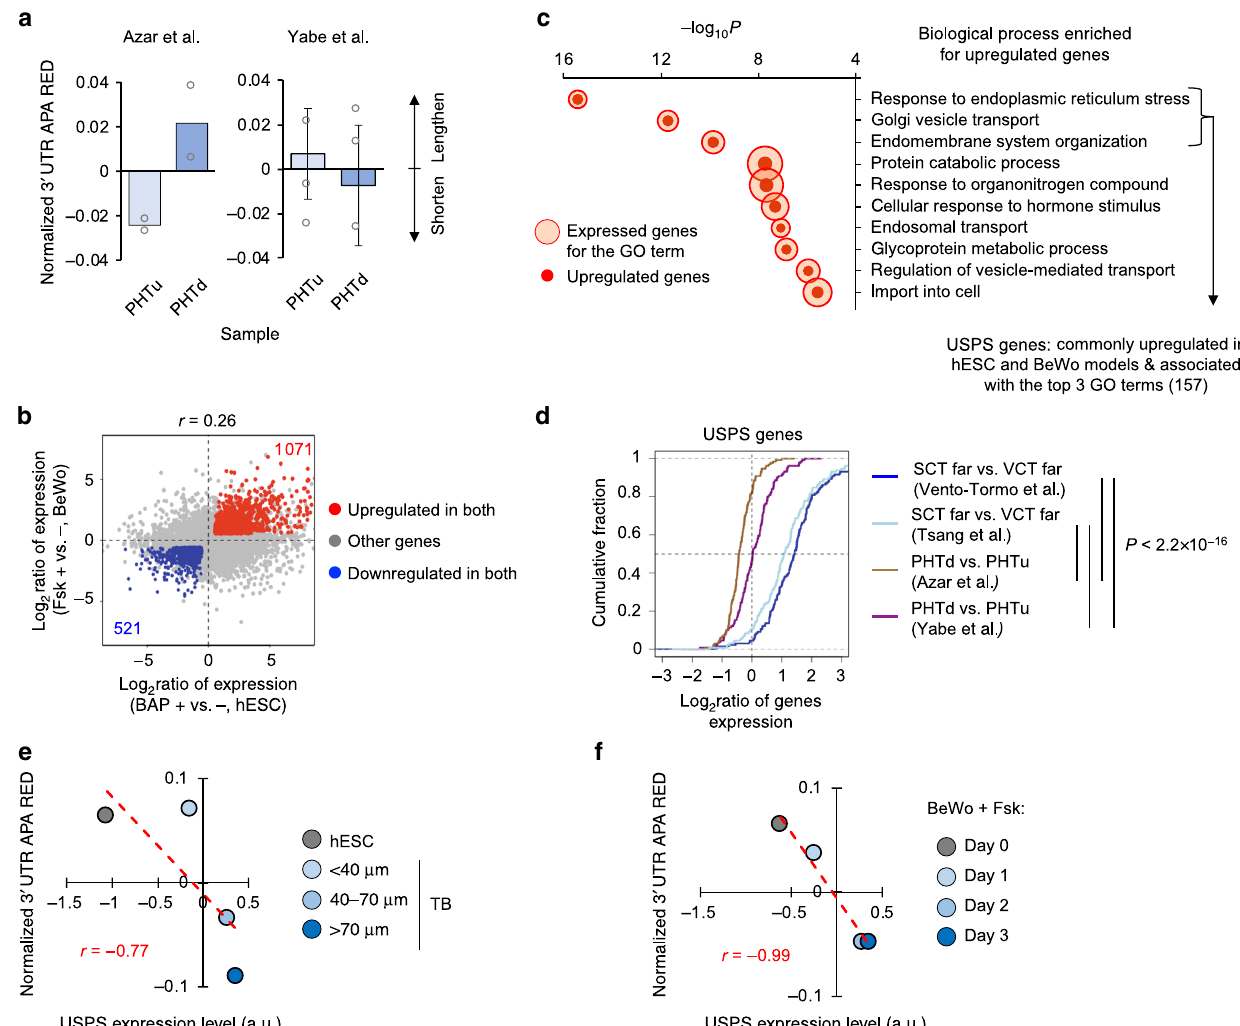
Fig. 5 Integrative analysis connects 3 ʹ UTR size regulation to protein secretion. a 3 ʹ UTR APA analysis of in vitro syncytialization of primary human trophoblast (PHT) cells. PHTu and PHTd are mononucleated PHT cells and syncytialized PHT cells, respectively. 3 ʹ UTR APA REDs are normalized to mean of all samples. Error bars are standard deviation based on two samples. n.s., P ≥ 0.05 ( t -test). b Signi fi cantly regulated genes in hESC and BeWo models. Signi fi cance of regulation is based on fold change > 1.2 and FDR = 0.05 (DESeq) in both models. The hESC model data correspond to > 70 μ m TB cells vs. hESCs (Fig. 3c) and the BeWo model data correspond to Fsk + vs. Fsk- (Fig. 3e). Commonly regulated genes are highlighted. Red for upregulation and blue for downregulation. Pearson correlation coef fi cient ( r ) comparing gene regulation in the two models is indicated. c Bubble plot showing top GO terms (Biological Processes only) enriched for genes upregulated in both hESC and BeWo models. Each GO term is represented by a circle, whose size re fl ects the number of genes associated with the term, and also by a dot, whose size re fl ects the number of upregulated genes associated with the term. All sizes are relative to other circles in the plot. For example, the term “ response to endoplasmic reticulum stress ” is associated with 273 genes, of which 62 are upregulated. De fi nition of USPS (3 ʹ UTR size-related protein secretion) genes (157 in total) is indicated. d CDF curves for USPS gene expression changes in four datasets, including two in vitro syncytialization models shown in a and two single-cell datasets (SCT far vs. VCT far, Fig. 4). A total of 131 USPS genes with detectable expression in all datasets are used for analysis. P -values (K – S test) for signi fi cance of difference between gene sets are indicated. e , f Scatter plots showing correlation between 3 ʹ UTR REDs and USPS gene expression levels for the hESC model ( e ) and the BeWo model ( f ). 3 ʹ UTR APA REDs are normalized to median of all samples. a.u., arbitrary